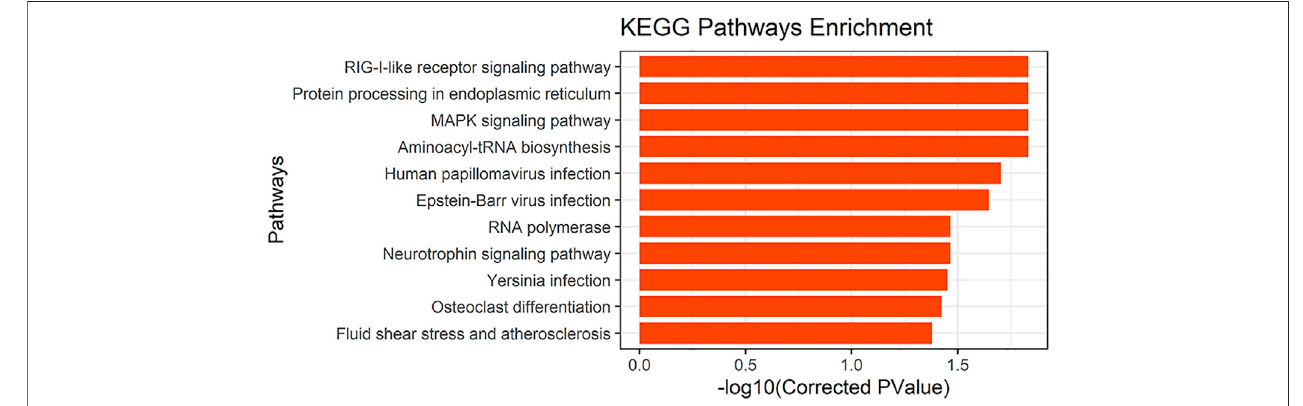
FIGURE 7 | KEGG pathways